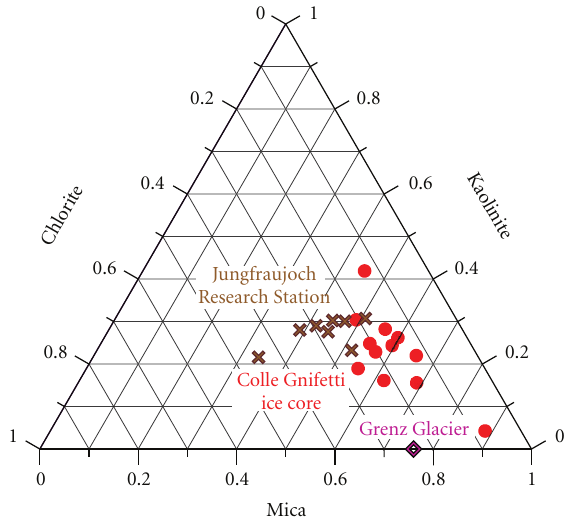
Figure 5: Kaolinite-mica-chlorite triangular diagram illustrating the clay mineralogy of samples from the Colle Gnifetti ice core (CG, circles), the Jungfraujoch Research Station (JFJ, crosses), and the Grenz Glacier sample